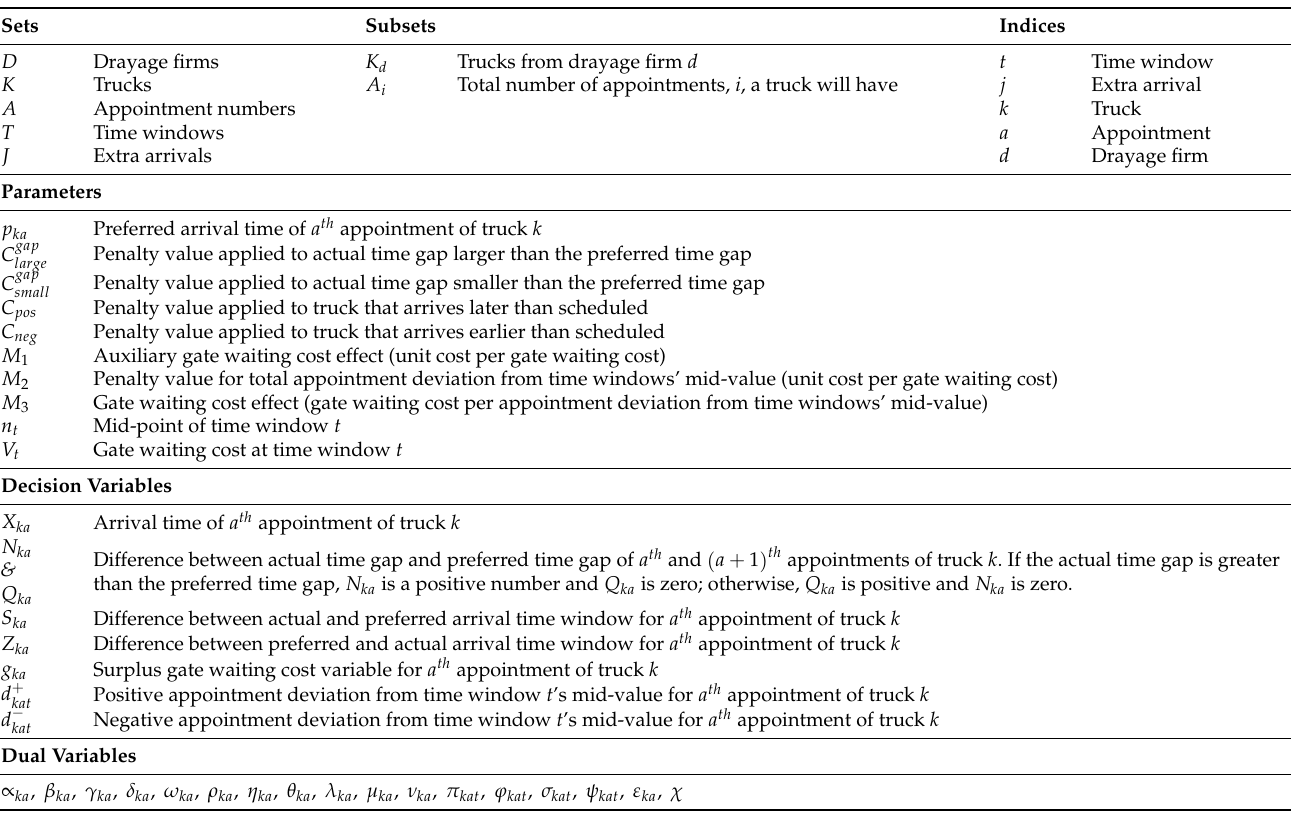
Table 2. Notation for the lower-level drayage firm